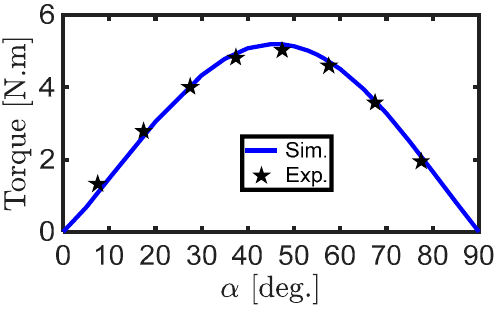
Figure 15. Simulated and measured output torque at different current angles at half the rated current and half the rated speed.